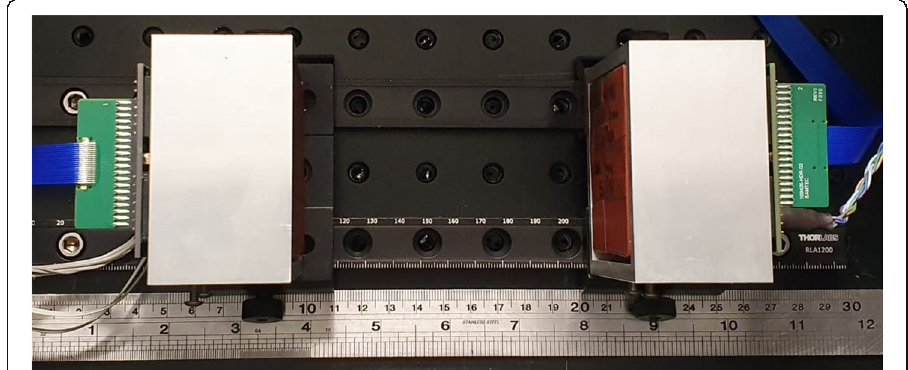
Fig. 3 Two detector modules, each consisting of a monolithic LYSO scintillation crystal, wrapped in white Teflon and brown tape. The crystals are coupled to SiPM arrays, SensL ArrayC-60035-64P, and mounted on aluminum cases, which in turn sit on a pair of optical rails to vary the detector separation